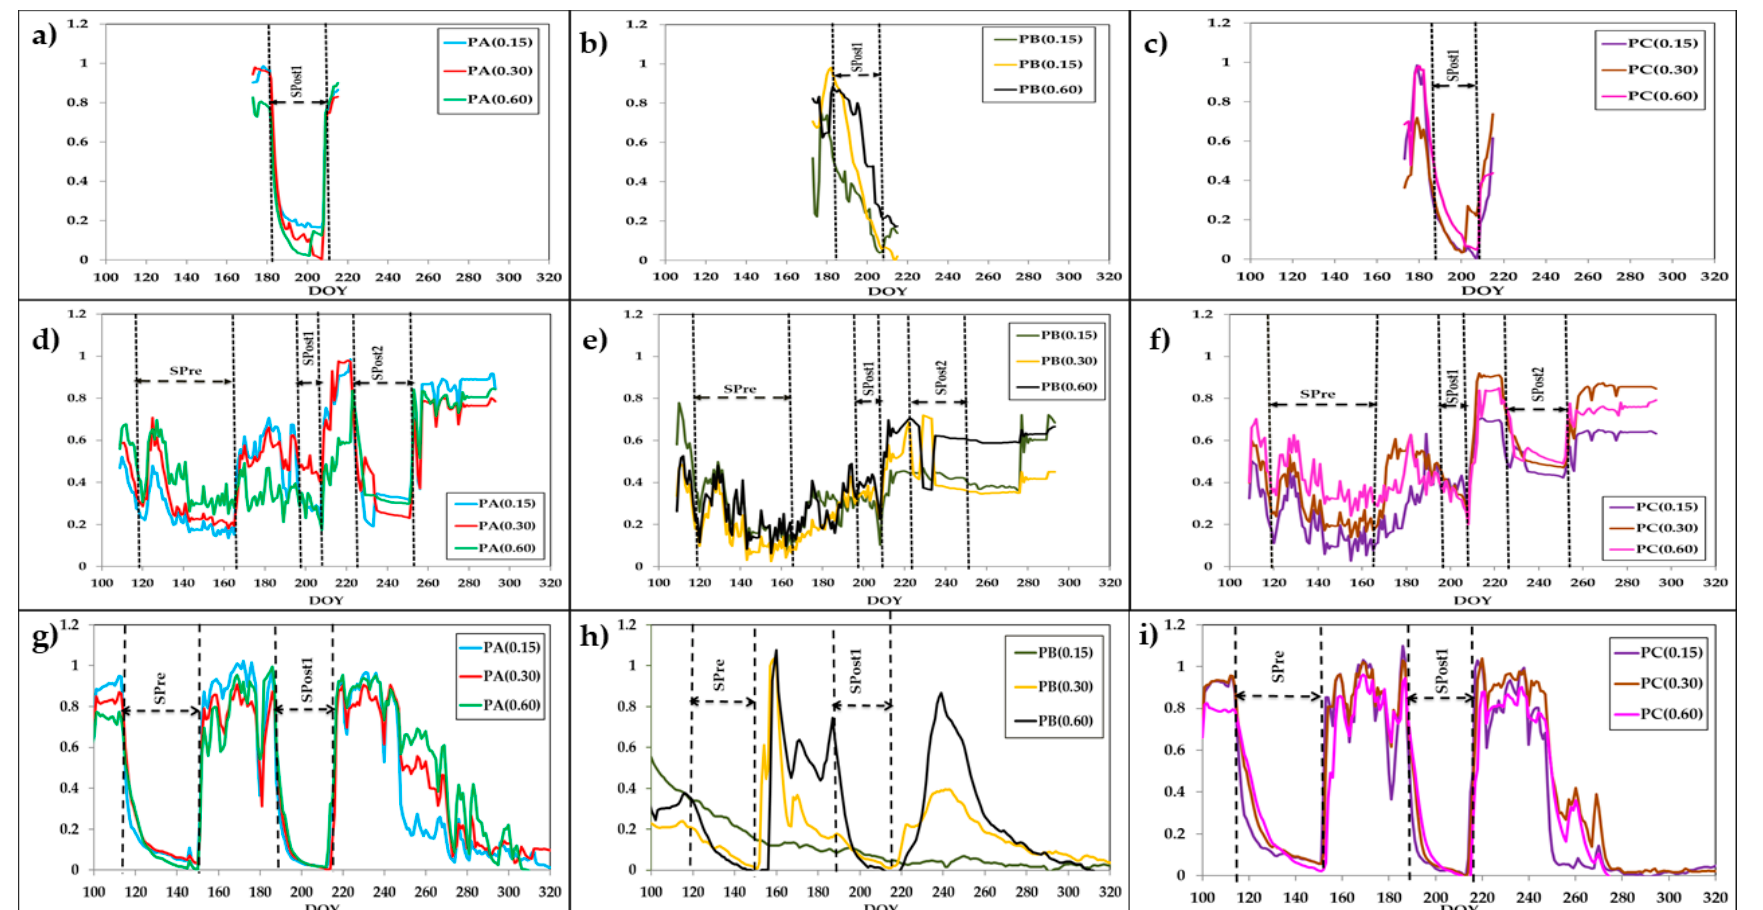
Figure 5. Seasonal evolution of relative soil water content (RSWC) measured by FDR probes located in different positions in the three years of study ( a – c ) 2015, ( d – f ) 2016 and ( g – i ) 2017. PA, PB and PC are positions A, B and C, respectively, where the capacitance probes were installed. The depth in meters to which the probe was installed is shown in brackets. Values are averages of three FDR sensors. The black vertical line corresponds to the beginning and end of each drying cycle. DOY, day of the year.